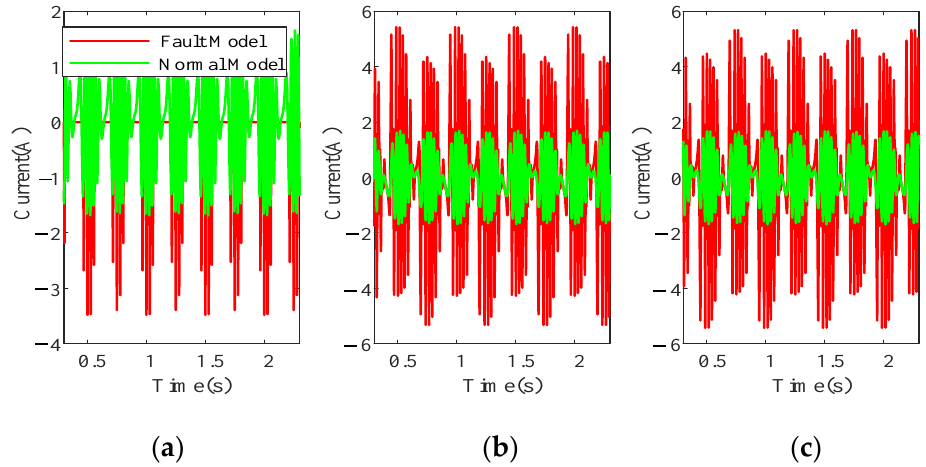
Figure 11. Fault data of A-phase lower-bridge IGBT open circuit. ( a ) A-phase current; ( b ) B-phase current. ( c ) C-phase current.